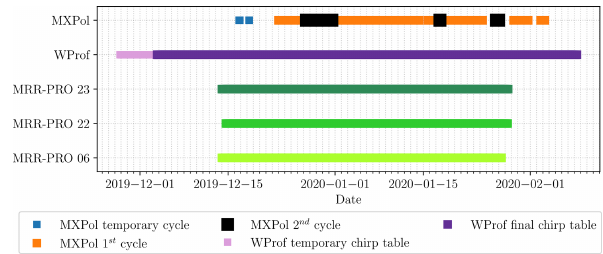
Figure 2. Time at which measurements have been collected by the five radars. The time series at the top of the figure is divided ac- cording to the scan cycles of MXPol. The blue markers denote the date and time of execution of scans in the temporary cycle, the or- ange ones denote the scans in the first cycle, and the black ones denote the scans in the second cycle. The second time series is di- vided according to the chirp table used by the vertically pointing W-band Doppler cloud radar (WProf): the definitive one, used for most of the campaign, is shown in purple, while the temporary ones preceding it are shown in pink. The time series of the three Micro Rain Radars PRO (MRR-PRO) are shown as three different shades of green in the three bottom rows of the panel.